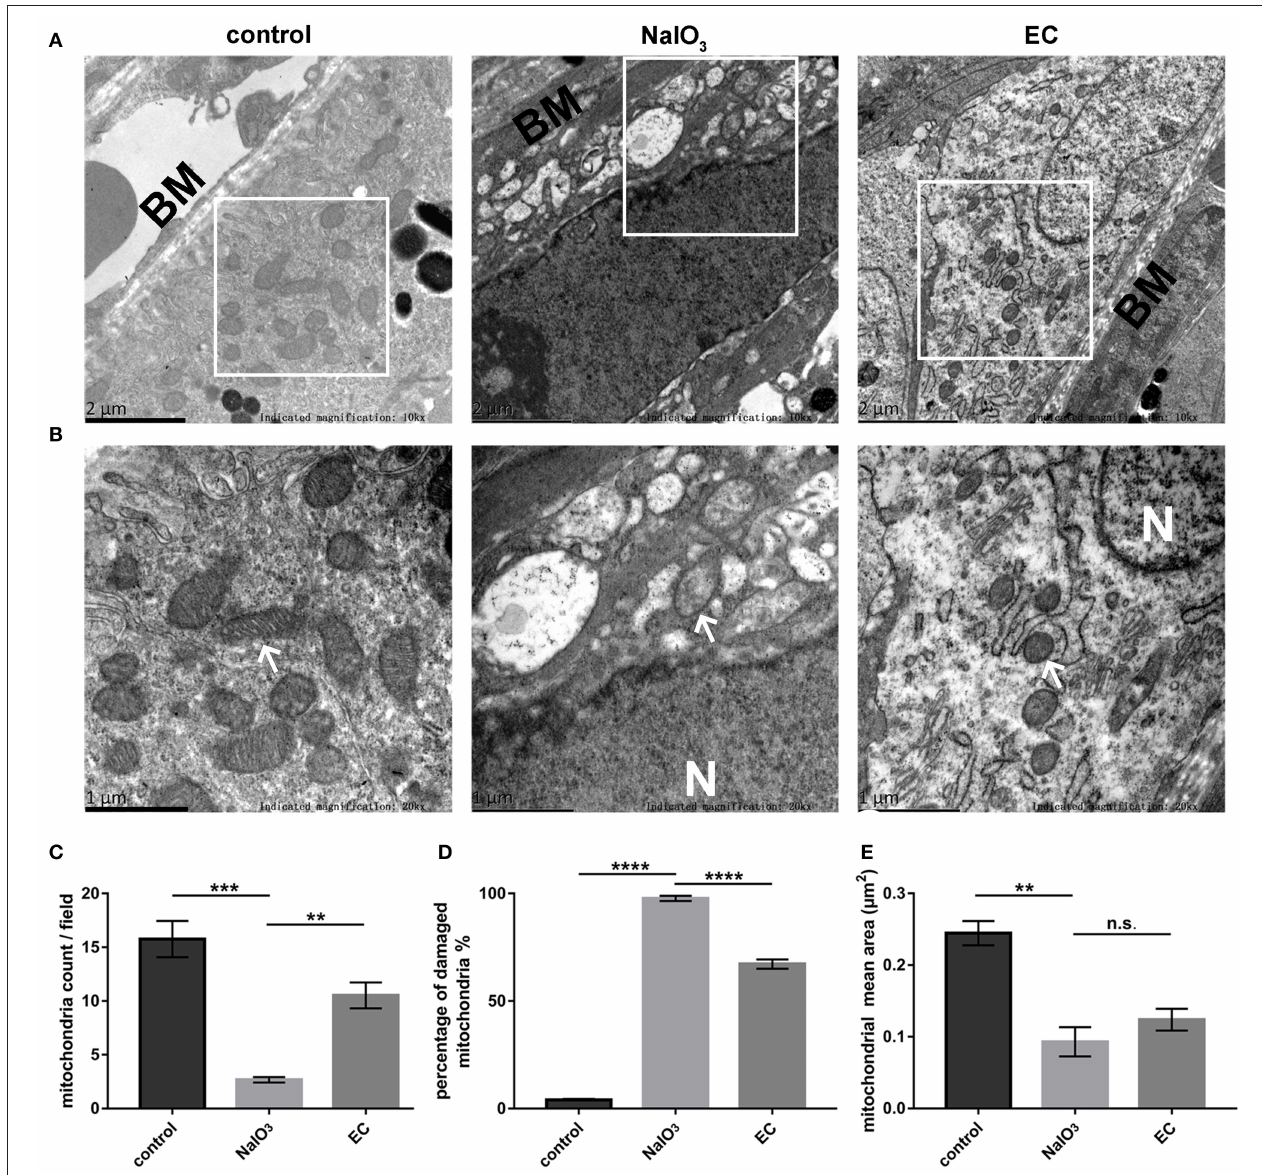
FIGURE 7 | RPE mitochondrial morphological changes detected by TEM 7 days after NaIO 3 administration. (A) and (B) Representative TEM micrographs show decreased mitochondria numbers, loss of cristae, and mitochondrial vacuolization in the NaIO 3 group; EC helped maintain normal mitochondrial morphology. Black BM indicates Bruch’s membrane. White arrows indicate mitochondria. White N indicates nucleus. Magnification: 10,000 × (bar = 2 µ m) and 20,000 × (bar = 1 µ m), respectively. (C) Total number of mitochondria per field were increased in the EC group compared to the NaIO 3 group. (D) Percentage of damaged mitochondria per field were decreased in the EC group compared to the NaIO 3 group. (E) There was no apparent difference in size of mitochondria between the NaIO 3 group and the EC group. Values are presented as mean with SEM; n = 4; n.s., no significance. ** p < 0.01, *** p < 0.001, **** p <